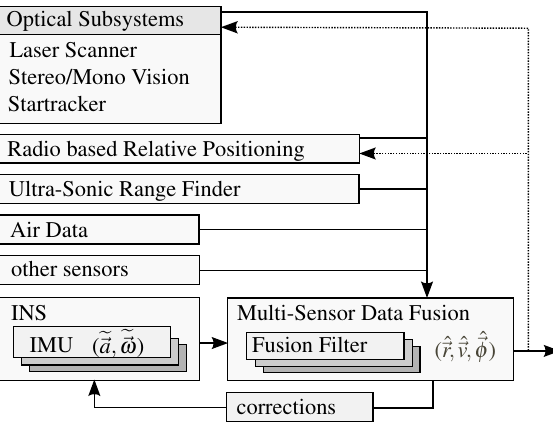
Figure 4: Multi-sensor data fusion of INS and the supporting sub- systems